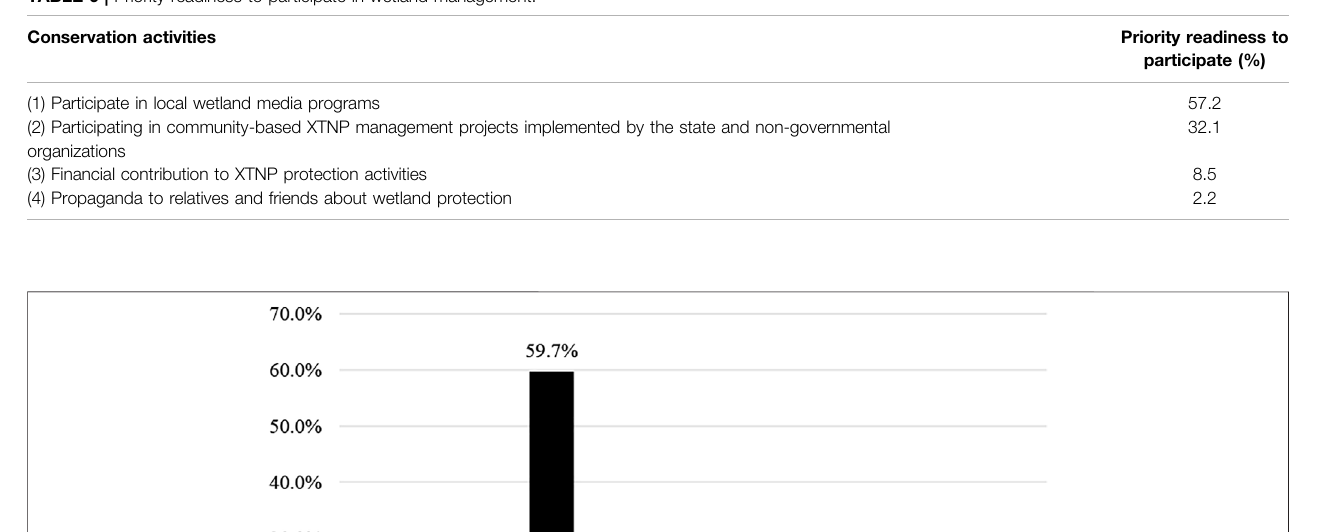
TABLE 6 | Priority readiness to participate in wetland management.